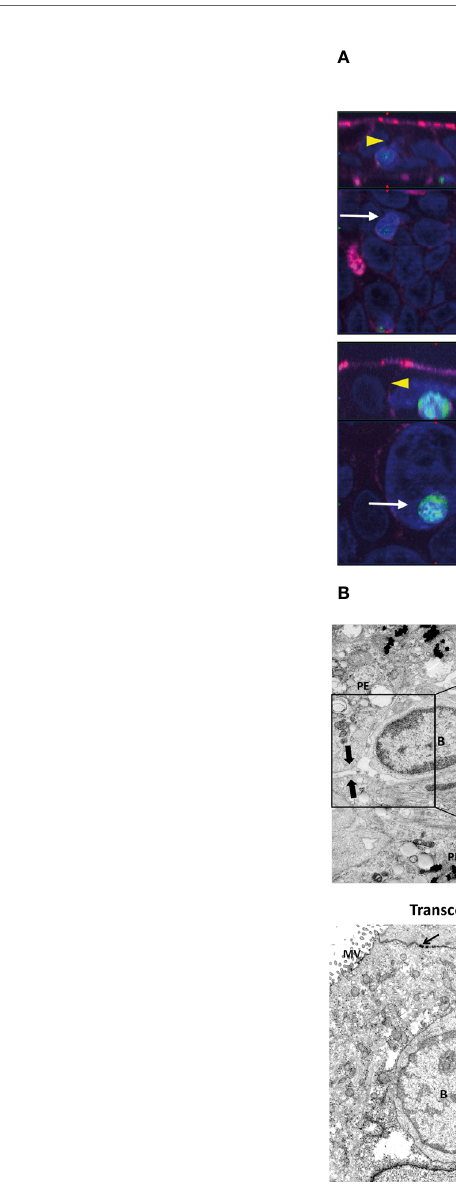
FIGURE 6 | Human B cells use both para- and transcellular diapedesis for transmigration through the choroid plexus epithelium. (A) Immuno fl uorescence analysis of B-cell migration across HIBCPP cells. Diapedesis of total CD19 + B cells obtained from healthy donors ( n = 15) was analyzed using immuno fl uorescent staining. After 4 h TM against a mix of CXCL12- and 13 the fi lters for nuclei were stained with DAPI (shown here in blue) and actin skeleton with phalloidin (shown here in pink). B lymphocytes (shown here in green) were labeled with Cell Trace ™ Calcein green before starting the migration. Z-stack images were taken using an ApoTome (Zeiss) and represented through display of a cross section through the z-plane of multiple slices in combination with a two-dimensional view from the top of the cell layer. The polarized cells are oriented with the apical side pointing upwards or to the right and the basolateral side downwards or to the left. Localization of migrating B cells in relation to the actin skeleton is indicated by yellow arrowheads. The upper immuno fl uorescence image depicts a single B cell (white arrow) located in the intercellular space between several HIBCPP cells (blue) and thus, uses a paracellular route to cross the epithelium. The intercellular borders (yellow arrowheads) are visualized in the actin staining and can be clearly seen above the migrating B cell (white arrow). The lower image maps a single B cell (white arrow) located inside a HIBCPP cell, at a clear distance from the cell borders (yellow arrowheads), which is in favor of transcellular diapedesis. Images shown are representative examples of multiple stainings taken from fi ve independent experiments each performed in triplicate. (B) For deeper analysis of B-cell diapedesis across HIBCPP cells total CD19 + B cells obtained from healthy donors ( n = 10) were analyzed using Transmission electron microscopy (TEM). After 4 h TM the fi lters were, therefore, fi xed in 2.5% glutaraldehyde, post fi xed with 1% osmium tetroxide, cut into strips, dehydrated, and embedded in epoxy resin. 60 nm ultrathin sections were cut with an ultramicrotome, contrasted with uranyl acetate/lead citrate, and analyzed with a TEM JEM140 equipped with a digital camera (TVIPS F420). Top: paracellular B-cell migration across HIBCPP clearly seen by a continuous intercellular route indicated by arrows. Higher magni fi cation shows the migrating rear part of a B cell, moving clearly intercellulary between epithelial cells. Bottom: transcellular B-cell migration across HIBCPP. One B cell is located inside an epithelial cell and migrates at a clear distance from the cell border. Scale bars: 3 µm. PE, plexus epithelial cell; B, B lymphocyte nucleus; arrows, desmosomes; M, mitochondrium; MV,